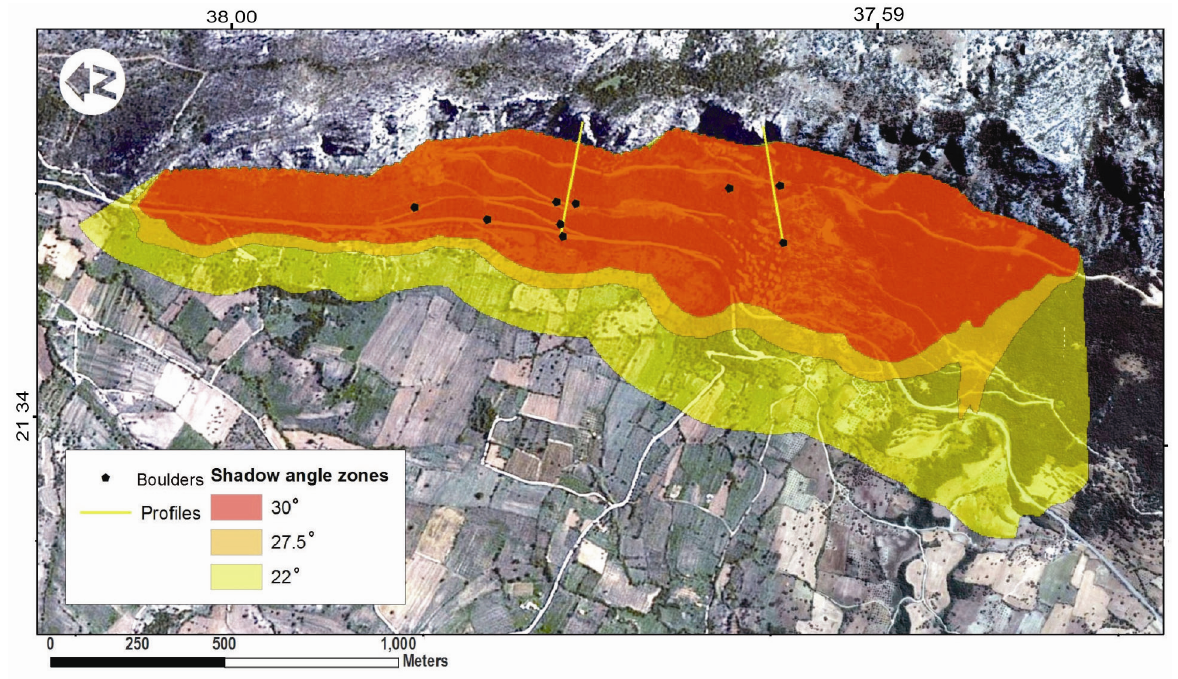
Figure 15. Shadow angle zones delineated using the values of 30°, 27.5° and 22°,